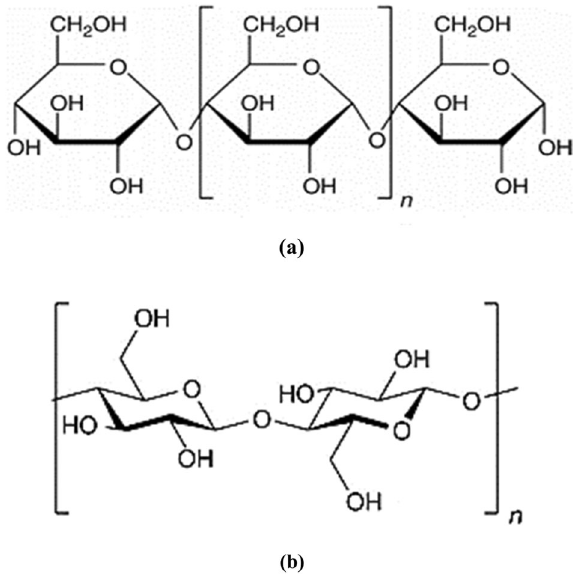
Fig. 4 Chemical structure. a starch, b